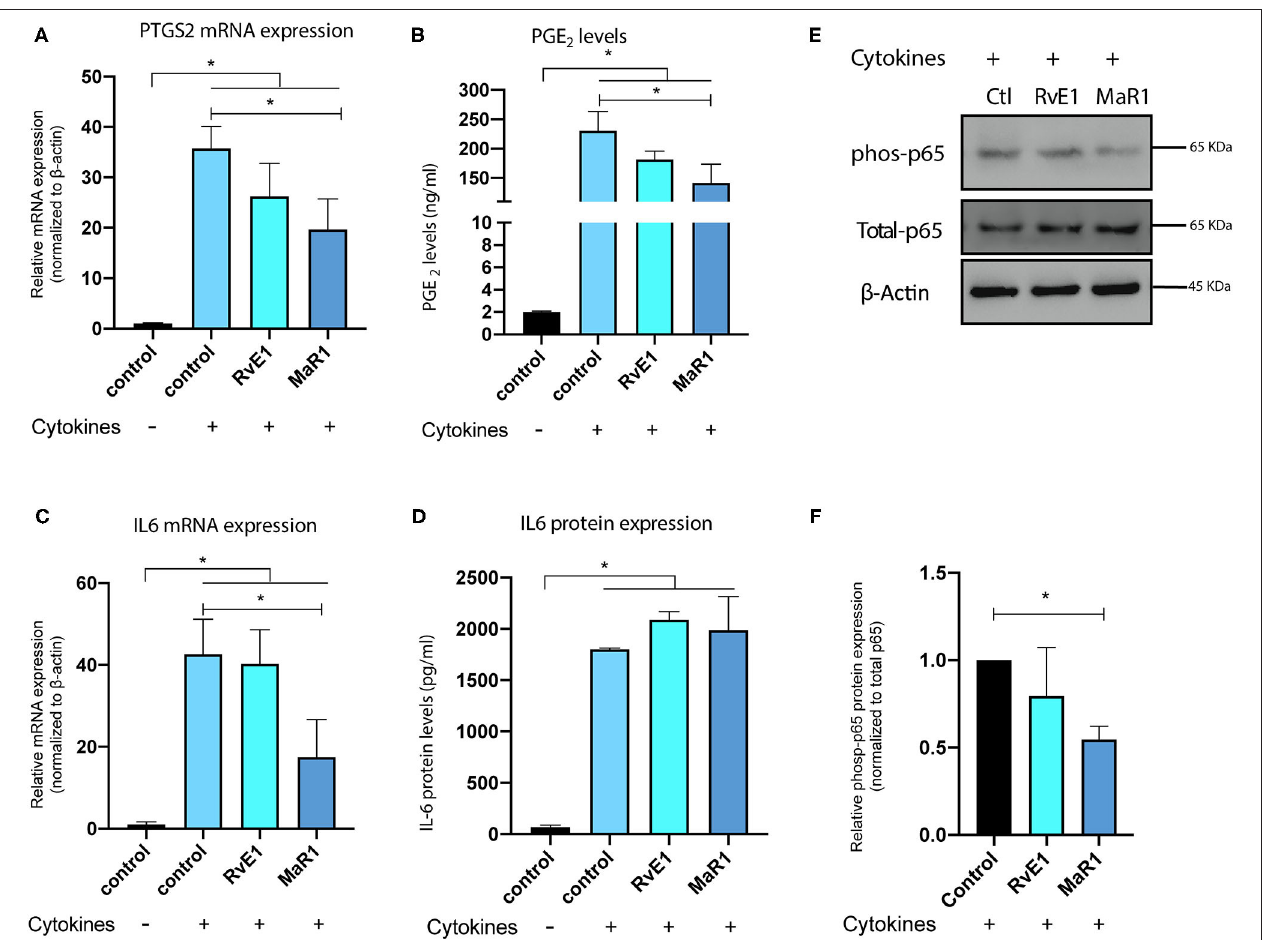
FIGURE 4 | SPMs lower the upregulated proinflammatory cytokines induced by combined IL-1 β and IL-17. PTGS2 and IL-6 mRNA levels were significantly elevated by the combined cytokine treatment after 24h challenge, but lowered by the addition of MaR1 (* p < 0.05) (A,C) . Prostaglandin E2 (PGE2) levels were significantly elevated by the combined cytokine treatment at 48h challenge and lowered by MaR1 treatment (B) . IL-6 protein levels were significantly elevated by the combined cytokine treatment, but not affected by SPM treatment (D) . Western blot showed that MaR1 reduced activation of the NF- κ B pathway (E) . Densitometry is shown in (F)